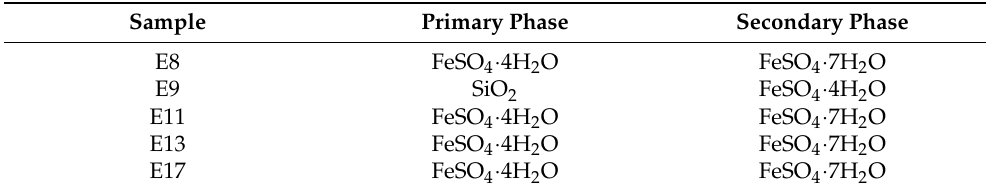
Table 2. Search–match results from the X-ray diffraction data collected for the E8, E9, E11, E13, and E17 dust samples.